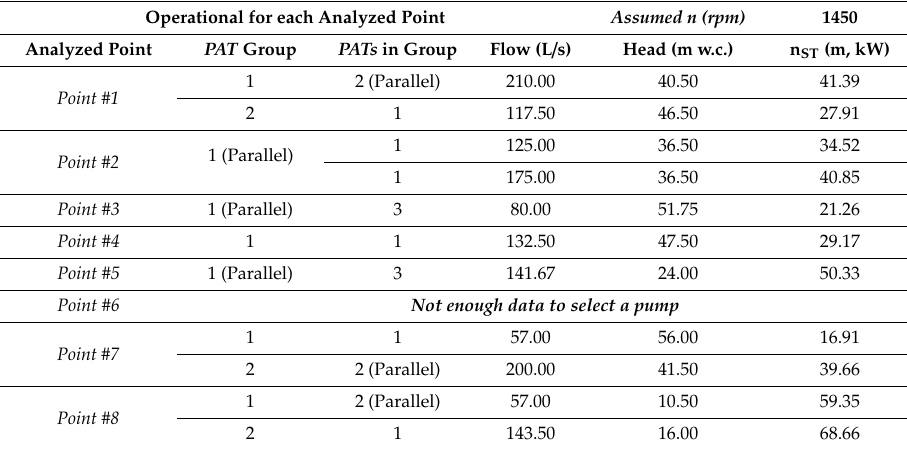
Table 9. Operational point for each PAT at every study case.